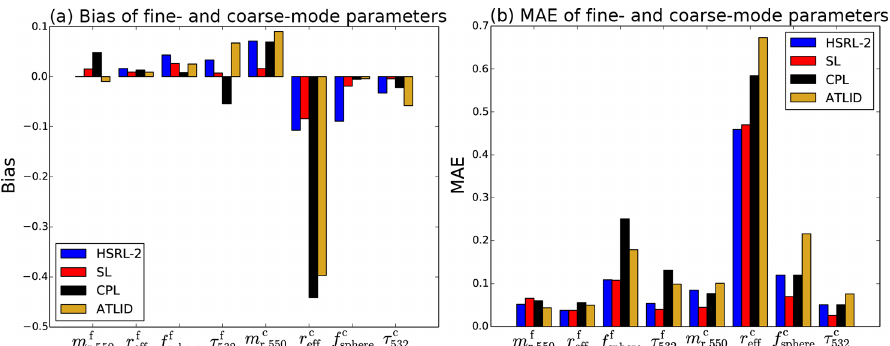
Figure 4. (a) Bias for each of the four instruments, for the various parameters, with panel (b) showing the corresponding values of MAE.